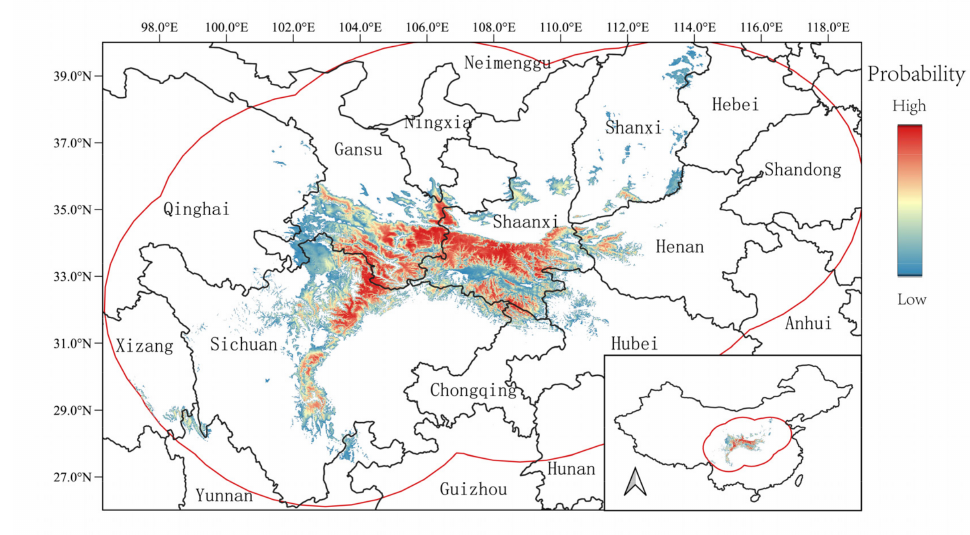
Figure 3. The current potential distribution of H. thibetanus